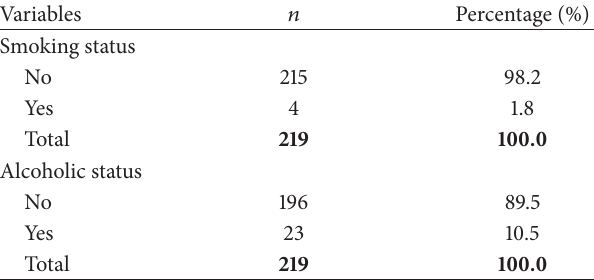
Table 1: Distribution of diabetic patients’ characteristics.